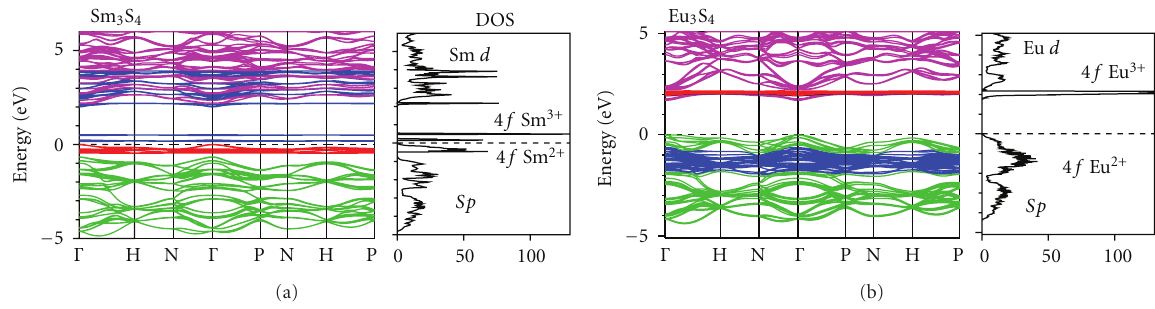
Figure 91: The energy band structure and total DOS (in states/(cell eV)) calculated for Sm 3 S 4 and Eu 3 S 4 calculated in the LSDA+ U approx- imation